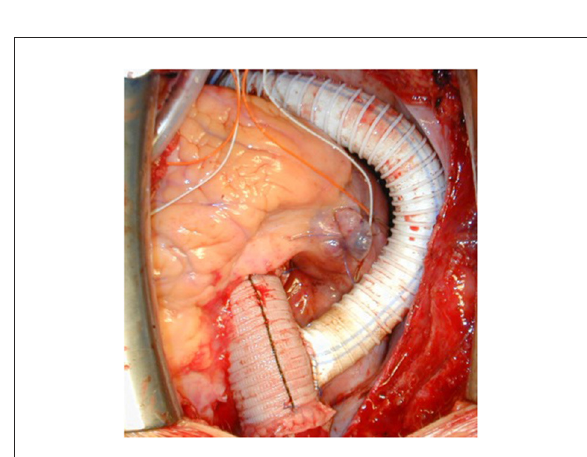
FIGURE11 Intraoperative view following replacement of the ascending aorta and ascending-descending bypass implanted laterally in the ascending aortic graft. Reproduced with permission